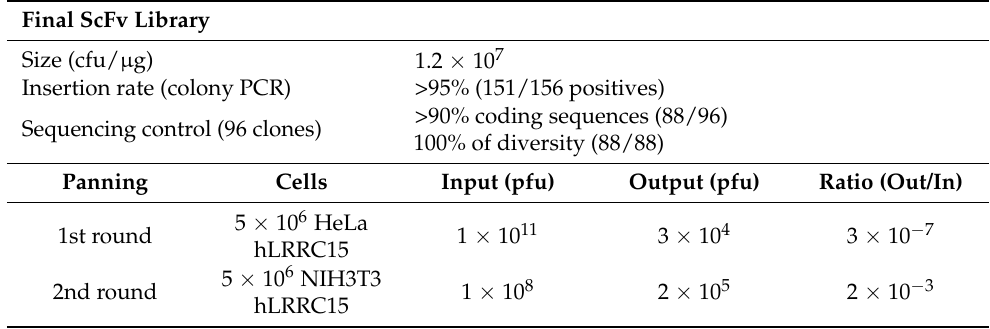
Table 2. ScFv library validation and panning